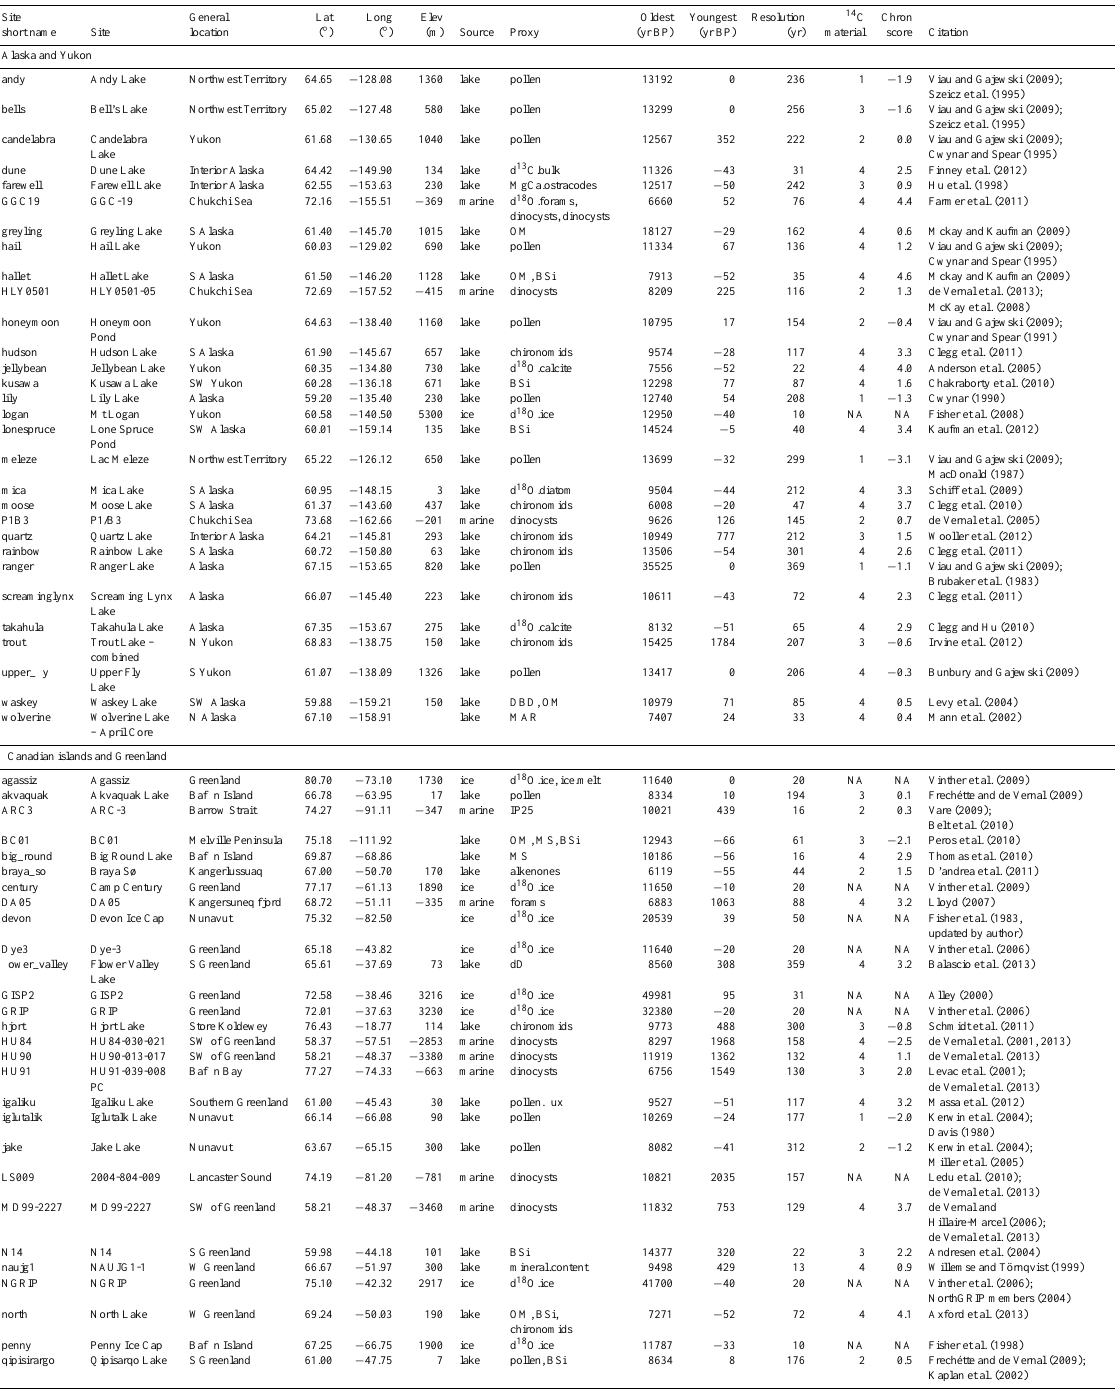
Table 1. Sites with proxy records in the database arranged by six Arctic regions. Some sites include more than one proxy record (see Table 2). (Notes: Site short name: title of tab in excel spreadsheet – database with proxy and geochronology data. Punctuation for proxy types connotes the following: x.y – x: general type of analysis, and y: specific type of analysis or material (e.g. “d 18 O.foram”: oxygen-isotope of foraminifera); x, y, z – different proxy records from the same site. Proxy type abbreviations as follows: BSi: biogenic-silica content; DBD: dry bulk density; MAR: mass accumulation rate; MS: magnetic susceptibility; N, C, S: nitrogen, carbon, sulfur; OM: organic-matter content; TOC: total organic carbon. Oldest and youngest ages are in calendar years before AD1950 (yr BP). Chron score: geochronology accuracy score calculated using the formulas and weighting factors in Appendix A and the “ 14 C material” type listed in the adjacent